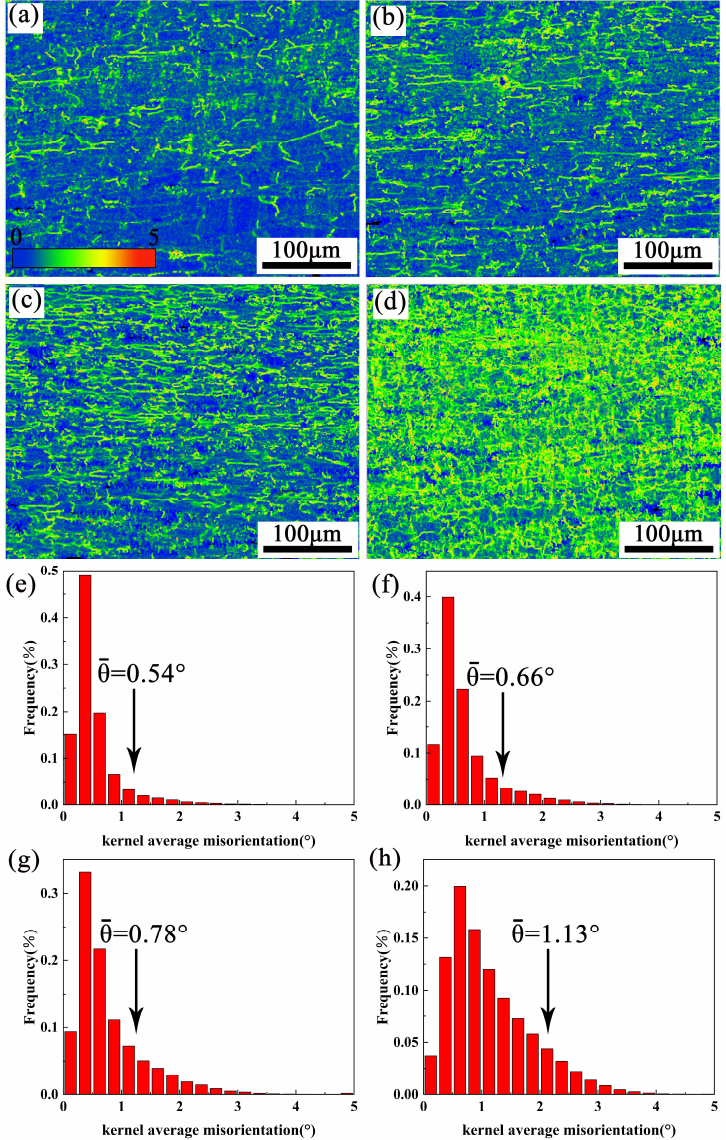
Figure 12. EBSD-kernel average misorientation (KAM) maps and local misorientation average angle of partial recrystallization for samples at 440 °C : ( a , e ) 0.001 s −1 , ( b , f ) 0.01 s −1 , ( c , g ) 0.1 s −1 , ( d , h ) 1 s −1 .